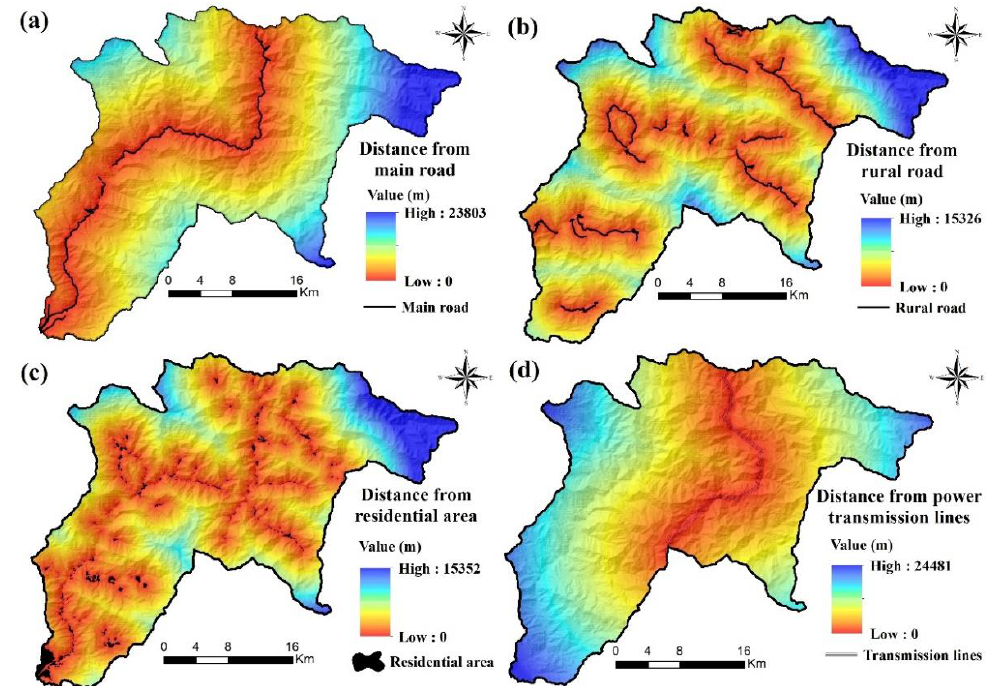
Table 5. A matrix of pair-wise comparisons of four criteria for determining weights in AHP method.